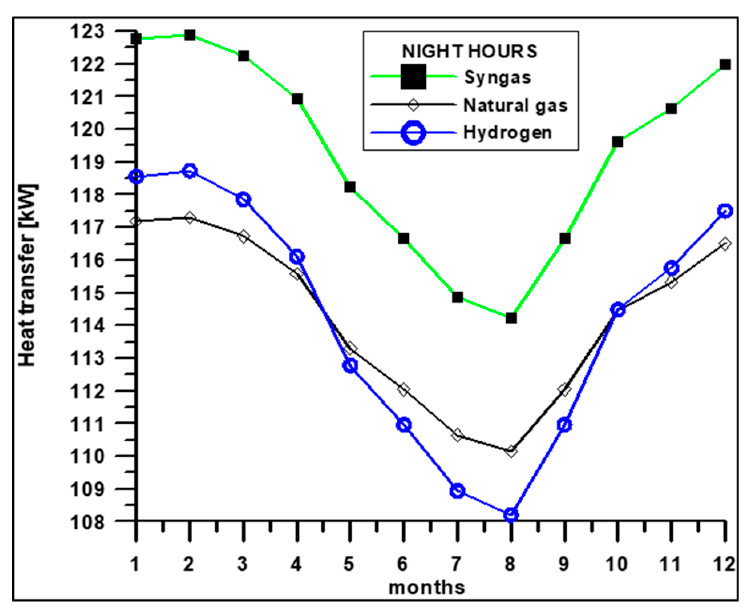
Energies 2020 , 13 , x FOR PEER REVIEW Figure 15. Net power in a year in night hours. Figure 15. Net power in a year in night hours.